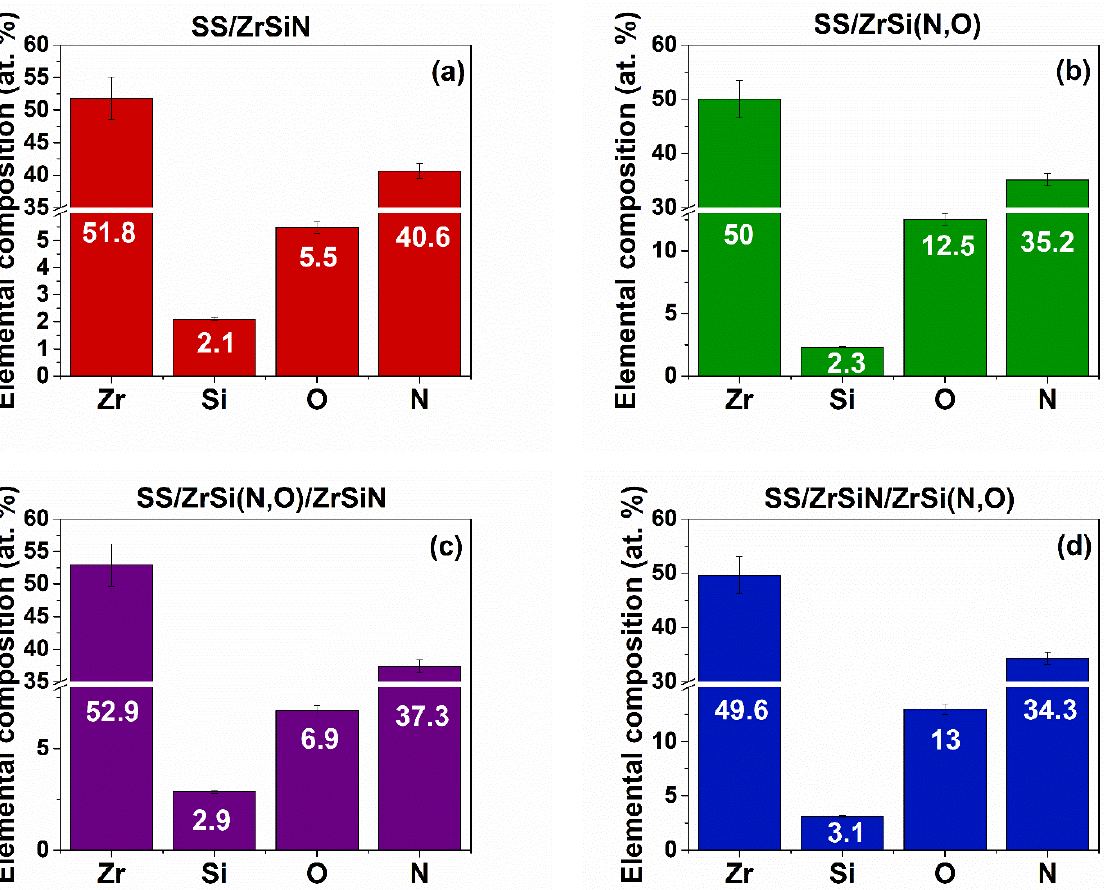
Figure 3. Elemental composition of the coated specimens: SS/ZrSiN ( a ), SS/ZrSi(N,O) ( b ), SS/ZrSi(N,O)/ZrSiN ( c ), and SS/ZrSiN/ZrSi(N,O) ( d ).